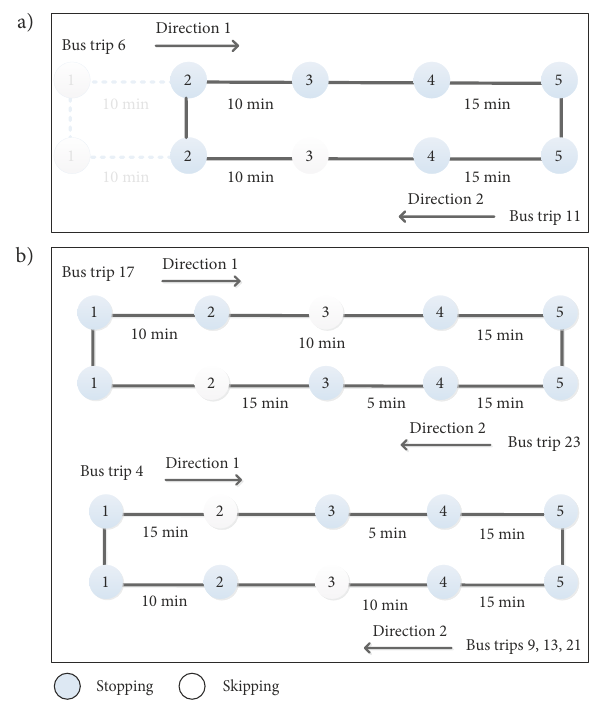
Figure 4. Optimal topologies of other strategies operated by bus trips: a – short turn strategy for trip 6 and mixed strategy for trip 11; b – limited stop strategy for trips 4, 9,13, 17, 21, 23 Table 3. Resulting timetable operated by FRO, limited stop, and mixed strategies